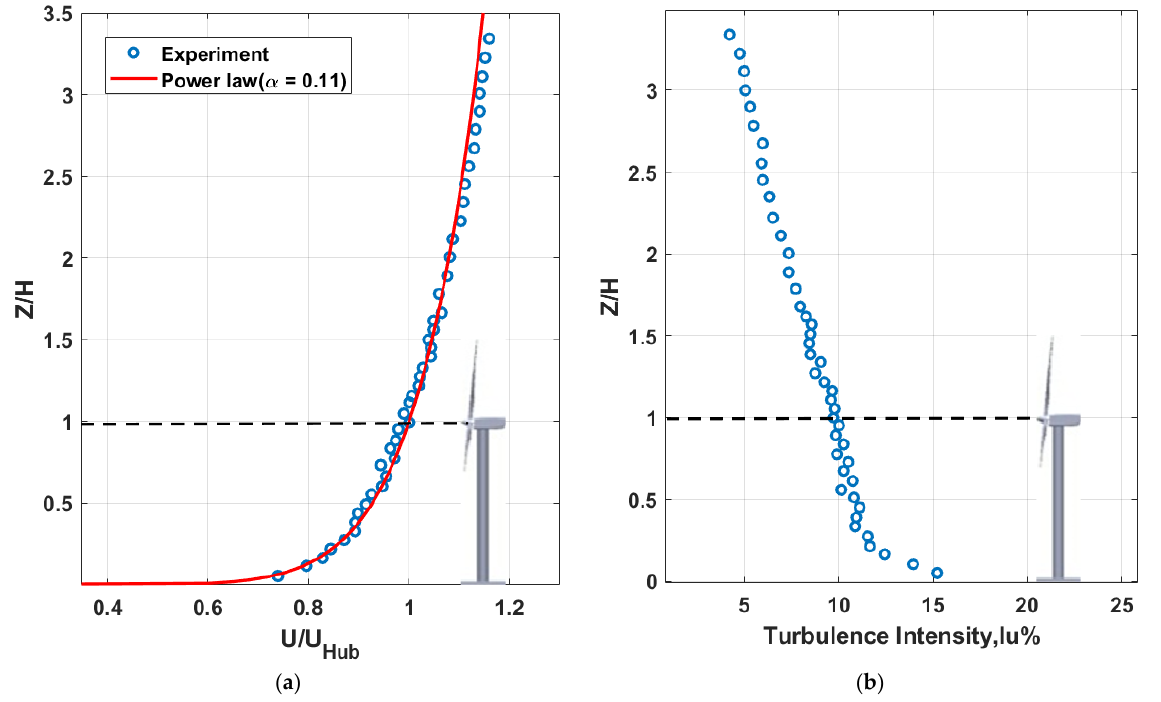
Figure 2. Flow characteristics of the incoming ABL wind used in the present study. ( a ) Measured mean velocity profile. ( b ) Measured turbulence intensity profile.